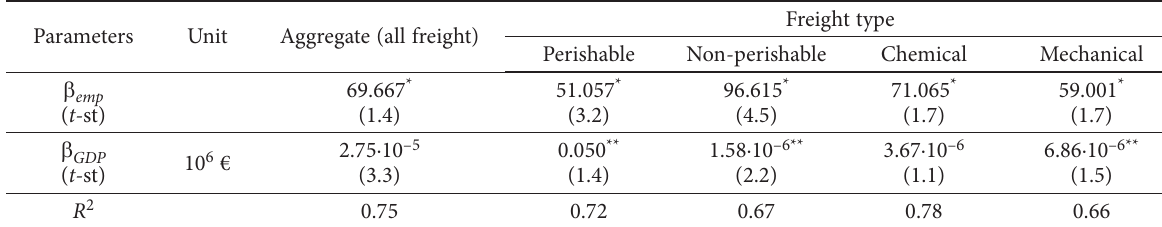
Table 5. Production model (export): calibration results in 10 3 tons/year